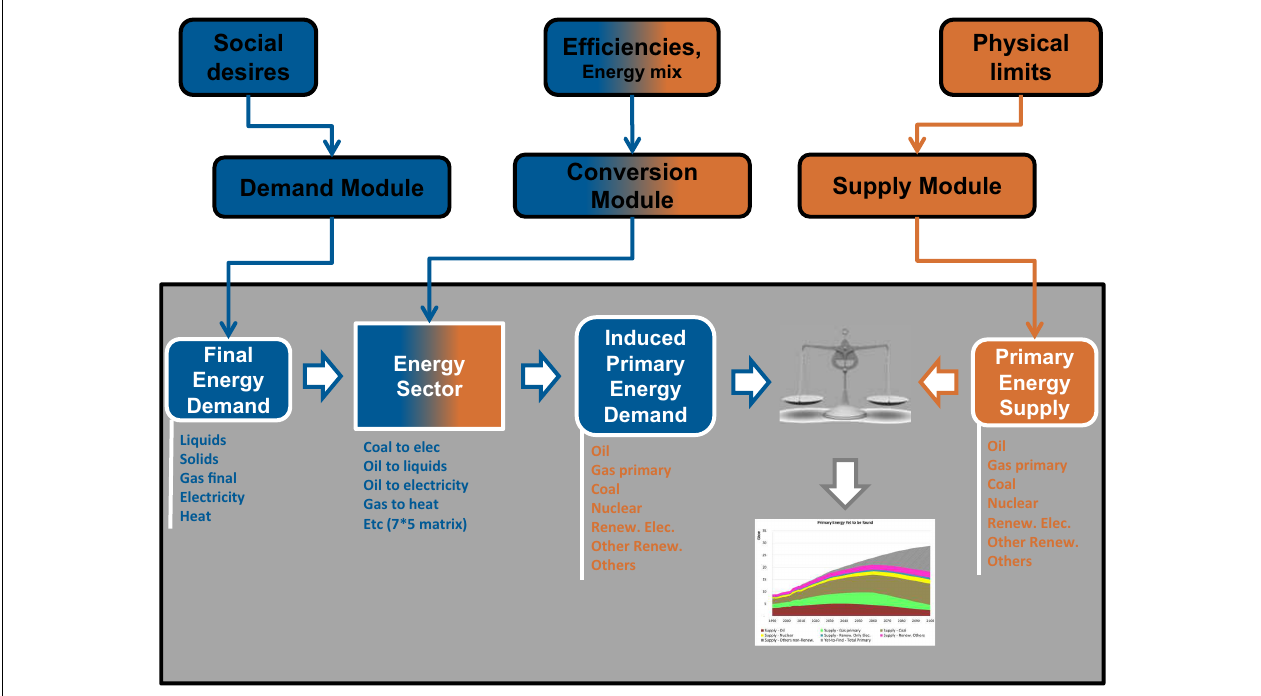
FIGURE 1 | Rogeaulito’s modeling principle and modules organization